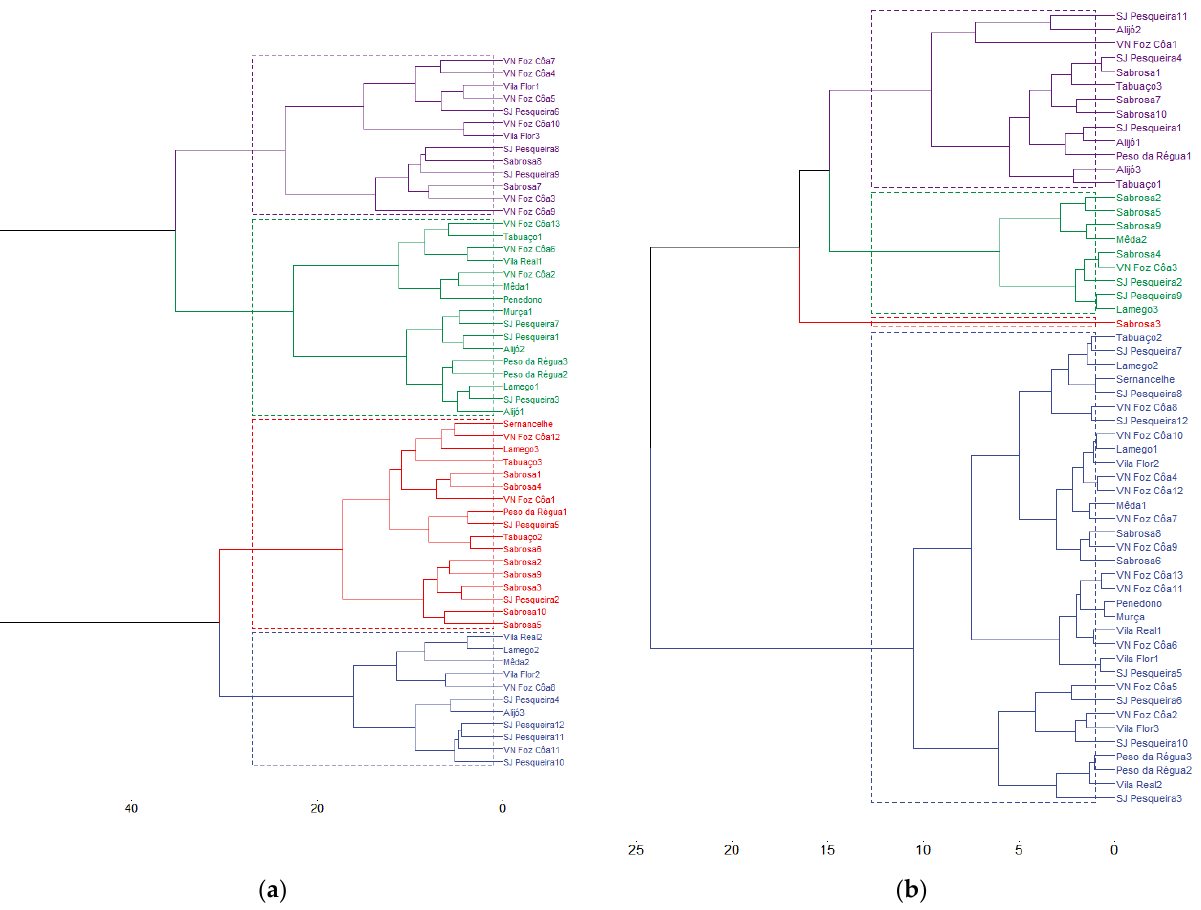
Figure 3. Dendrograms obtained from olfactory and gustatory sensations ( a ) and volatile profile ( b ) evaluated in olive oils from the Douro region.